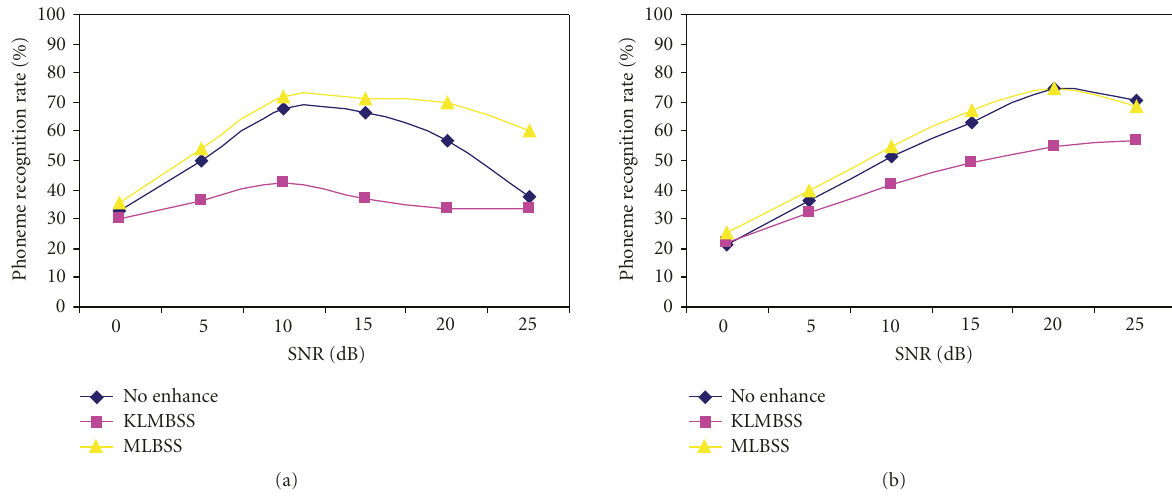
Figure 5: Phoneme recognition accuracy rate (%) as a function of the signal-to-noise ratio of the speech being recognized, where the recognition system has been trained on noisy speech. In (a) and (b), system has been trained with additive white noise at SNR 10dB and 20dB noisy speech, respectively. Table 3: Phoneme recognition accuracy (%) in changing SNR